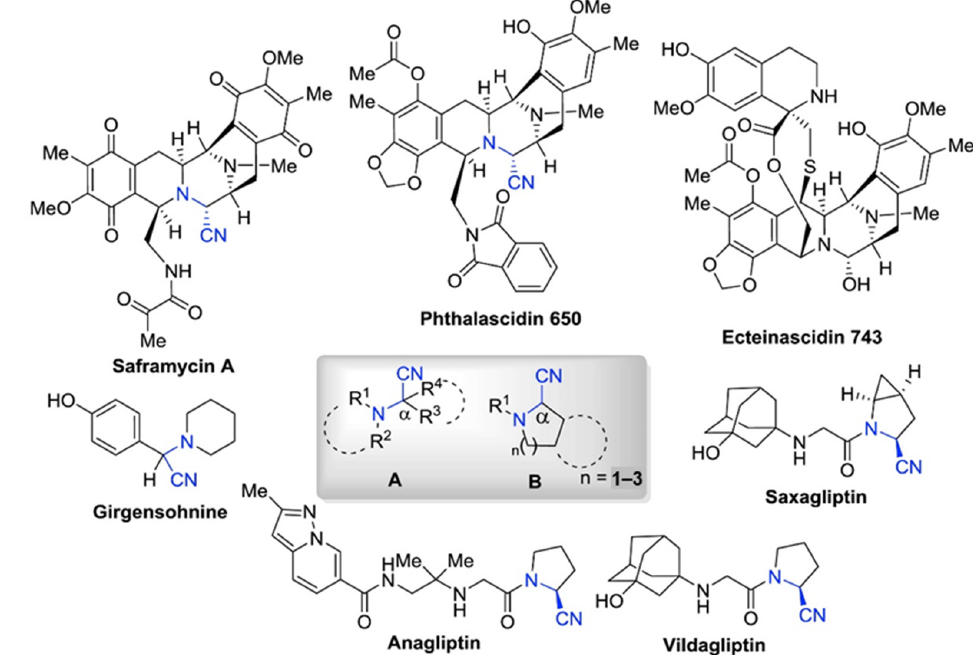
Figure 1. General structural types of α -aminonitriles. Representative biologically active α -amino nitrile-containing natural products and synthetic drugs. The general structure of these biologically active α -amino nitriles is represented in the highlighted box, where R 1 , R 2 , R 3 , and R 4 = alkyl, aryl [2]. Reprinted with permission from Ref. [2]. Copyright 2018, Elsevier Ltd